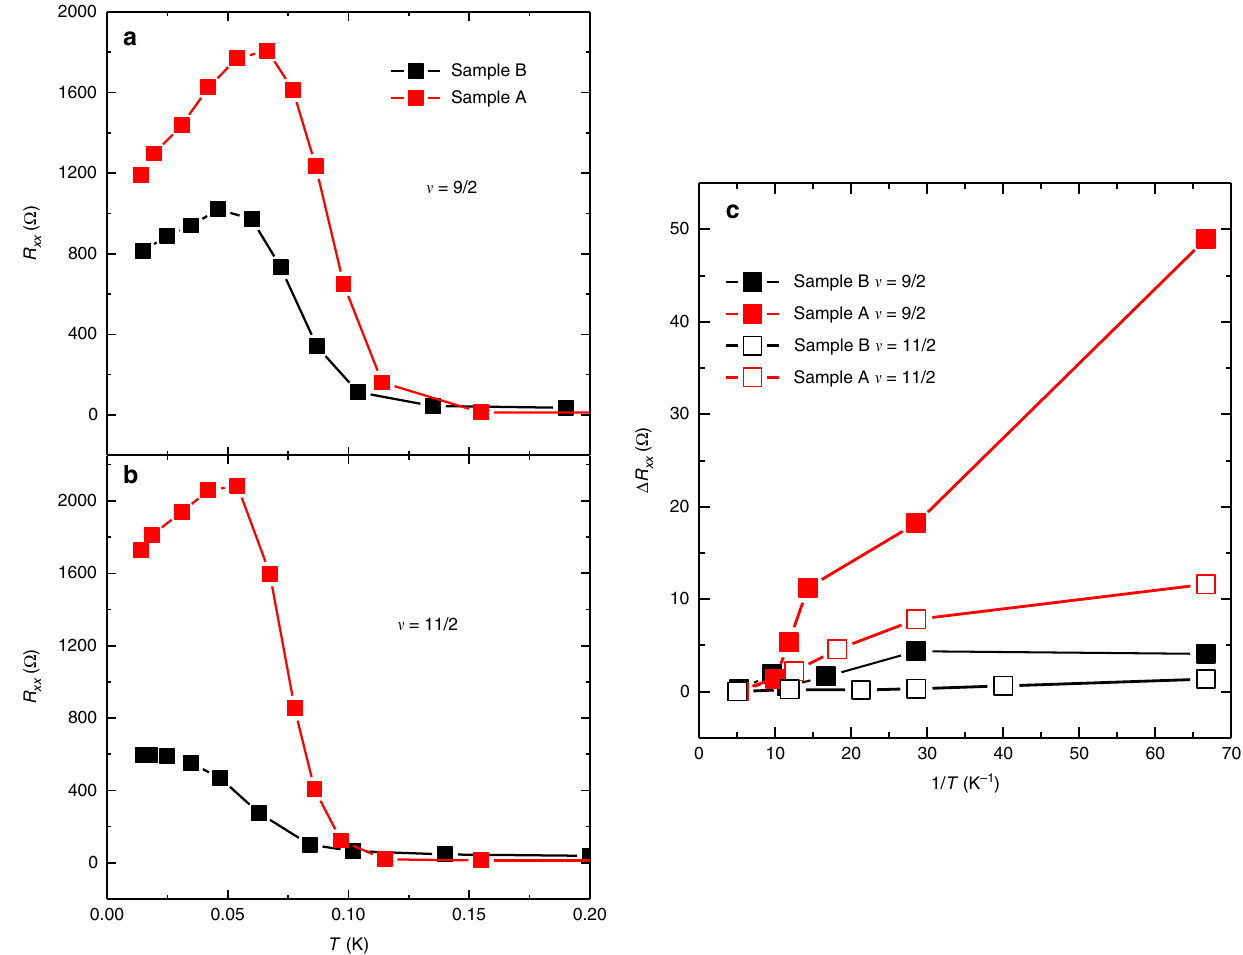
Fig. 5 Impact of disorder on turnover and noise in R xx . Field cooling of Sample A (red) and Sample B (black) at a ν = 9/2 and b ν = 11/2. Sample A has extremely low disorder, while Sample B has signi fi cantly higher disorder. c Noise amplitude for samples A and B at ν = 9/2 (open squares) and ν =